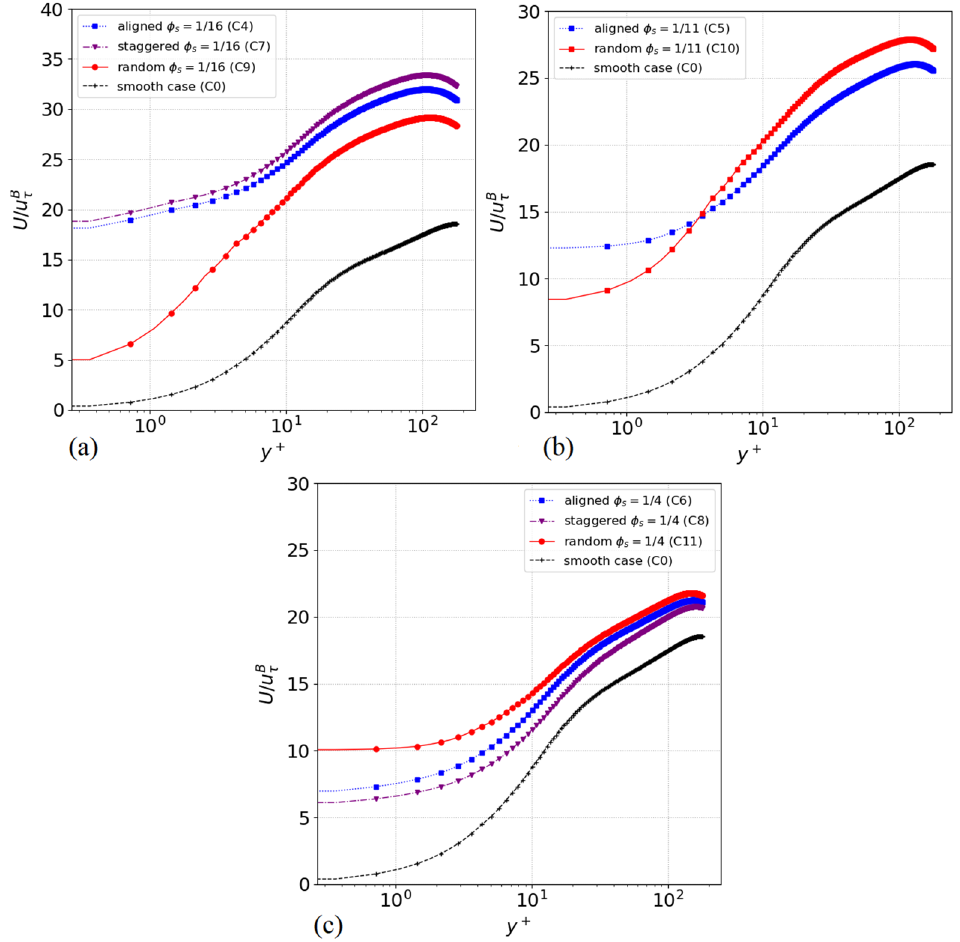
Figure 11. Slip velocity as a percentage of the bulk velocity for three different distributions of post types: ( a ) φ s = 1 , ( b ) φ s = 1 , and ( c ) φ s = 1 16 11 4